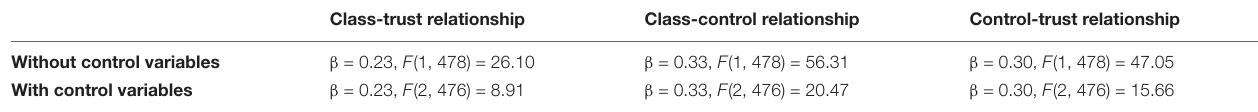
TABLE 1 | Relationships among social class, sense of control, and generalized trust. Class-trust relationship Class-control relationship